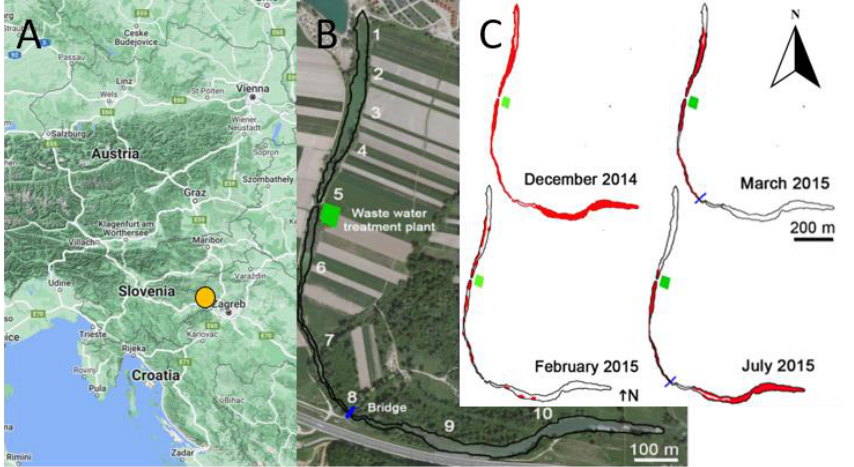
Figure 1. ( A ) Study site in Slovenia shown by the orange circle; ( B ) ten permanent sampling points along the thermal stream Topla (the green square indicates the location of the wastewater treatment plant); and ( C ) surface cover of P. stratiotes from December 2014 to July 2015 marked with color red.